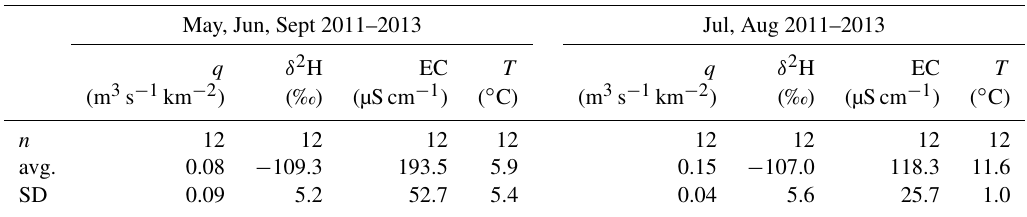
Table 7. Basic statistics of specific discharge, δ 2 H and EC for the two groups reported in Fig. 7 for data collected in the three sampling years. Abbreviations are used as in Table 2.